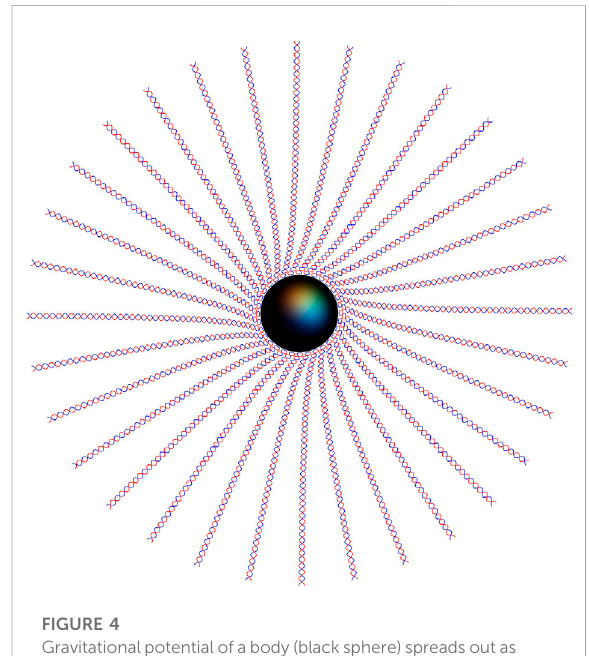
FIGURE 4 Gravitationalpotential ofabody (blacksphere)spreads outas paired-photon rays (sketched as red and blue waves) whose energy density decreases inversely with distance, r , observed as redshift. The paired-photon rays are dragged around a rotating body